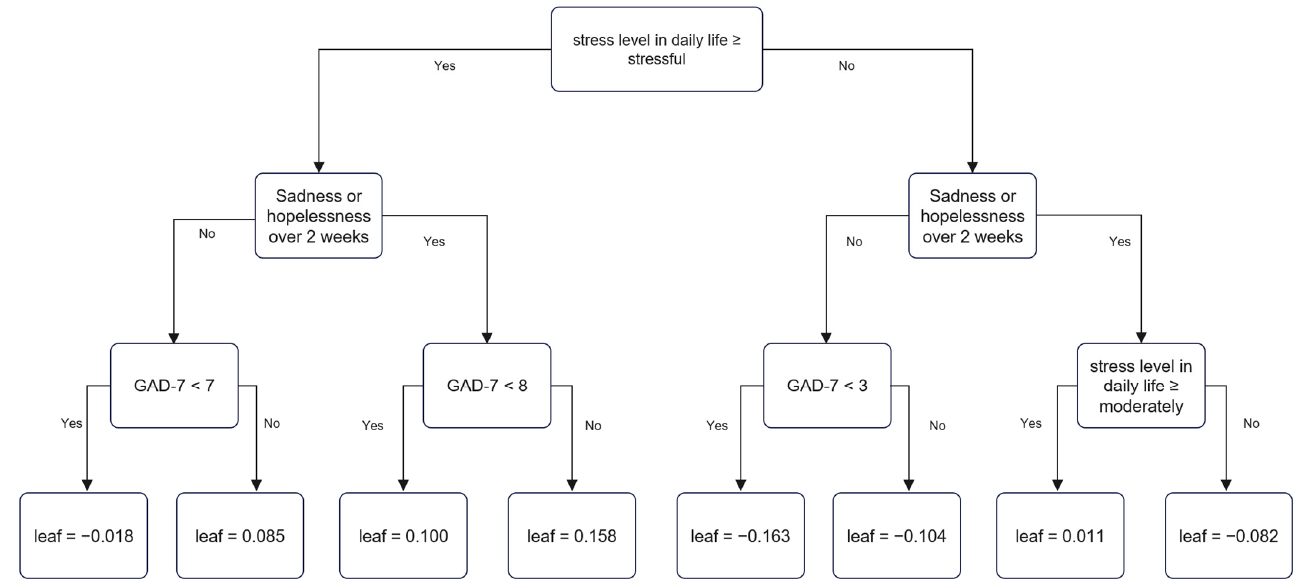
Figure 2. Decision tree of suicidal ideation in the medium socioeconomic status group by XGBoost.